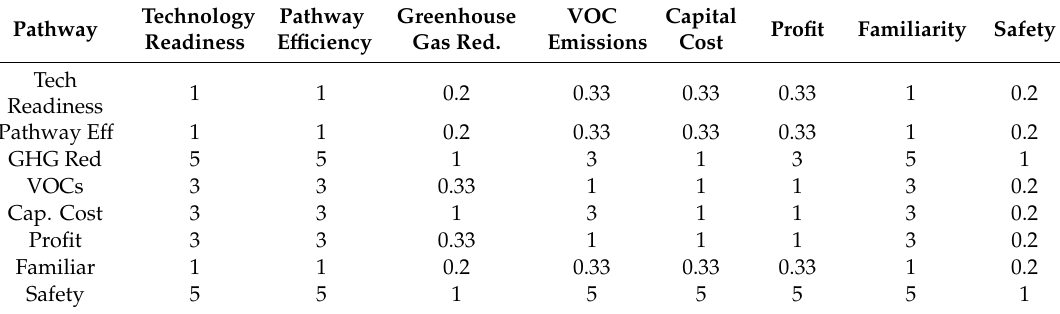
Table 16. Analytic Hierarchy Process Comparisons for Focus on GHG Reductions and Safety (Source: own